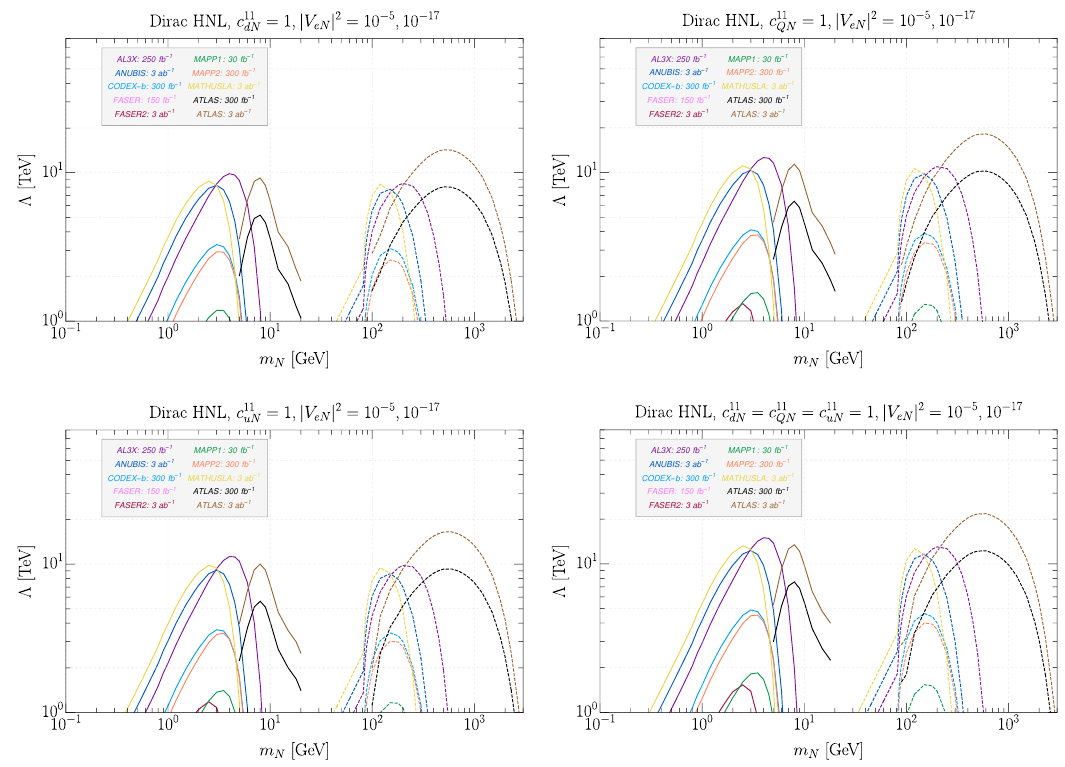
Figure 7 . Experimental sensitivity reach on the new physics scale Λ as a function of m N for Dirac HNLs. The values of the mixing with the active neutrinos have been fixed to | V eN | 2 = 10 − 5 (solid lines) and 10 − 17 (dashed lines). The four plots correspond to 4 different